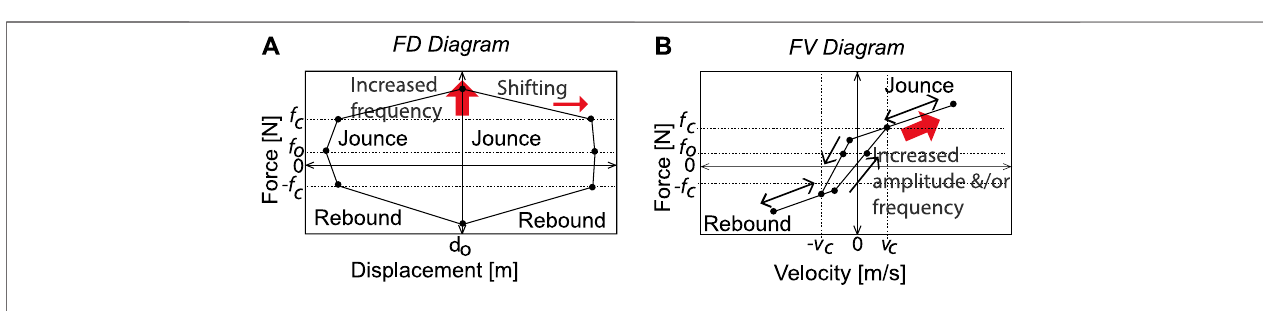
FIGURE 7 | Characteristic diagrams at ω M , Type-3